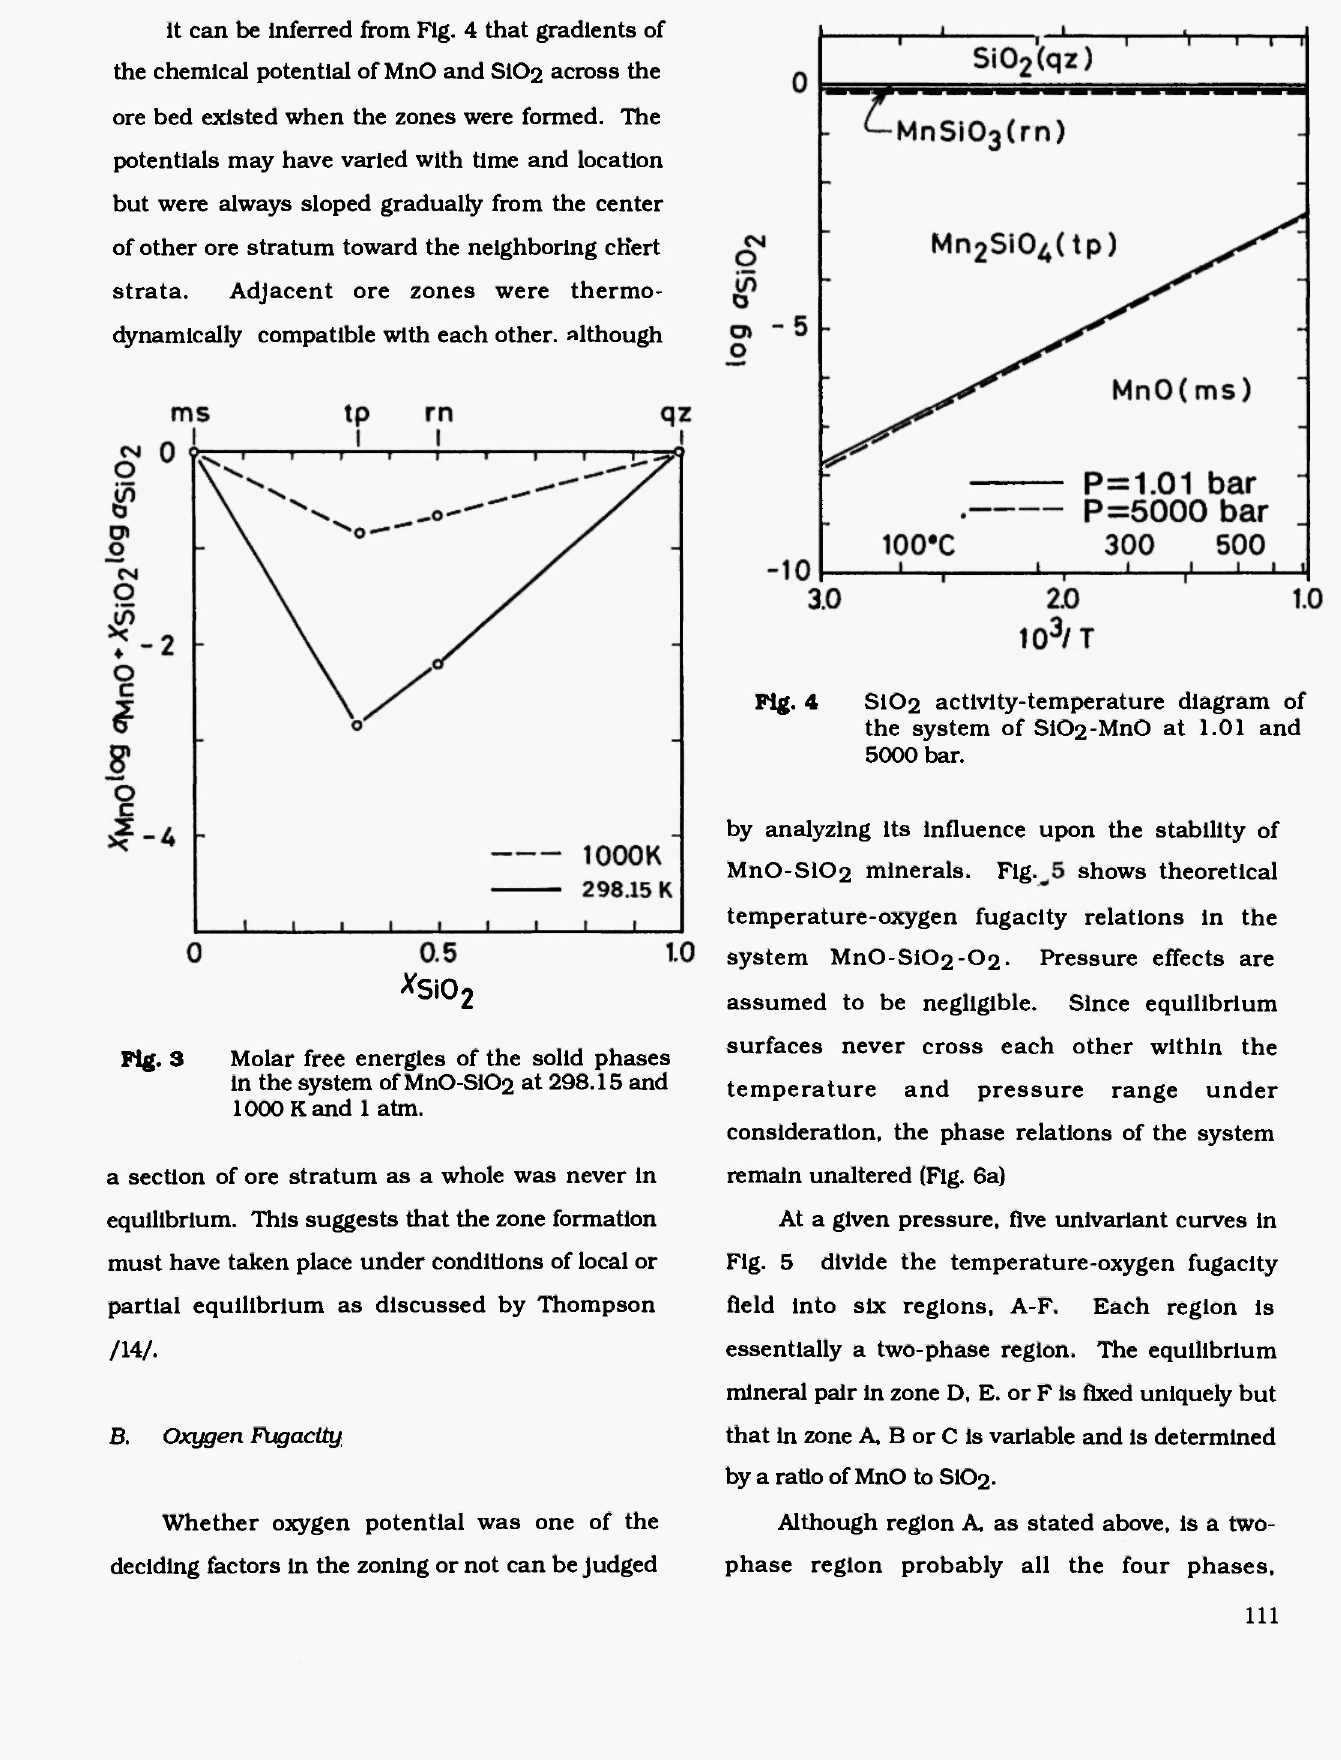
Fig. 4 SIO2 activity-temperature diagram of 5000